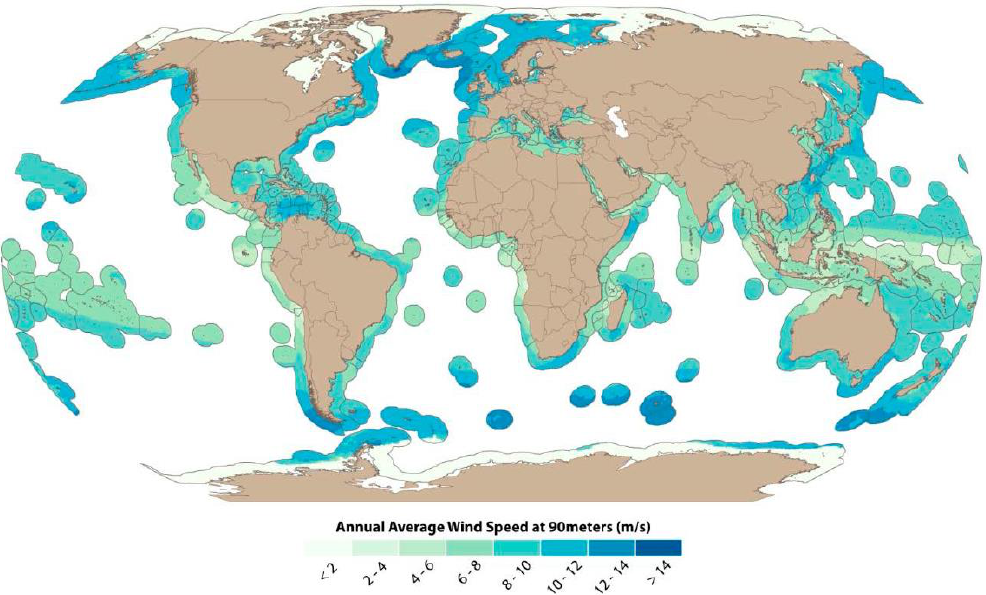
Figure 1. Annual average wind speed, in m / s, at 90 m high (Reproduced with permission from [34]. European Centre for Medium-Range Weather Forecasts, 2019).